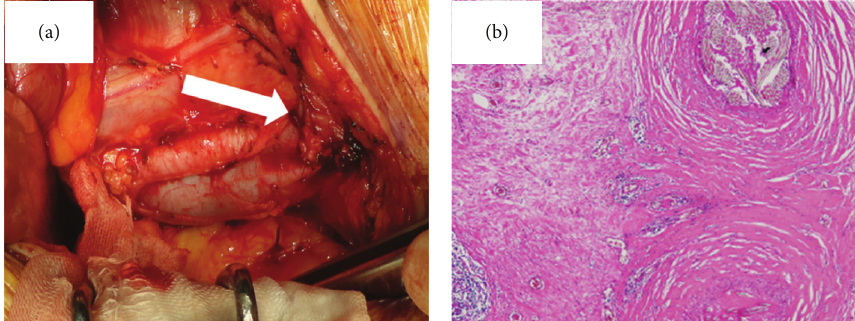
Figure 2: (a) The intraoperative findings revealed tumors near the left femoral artery and vein (arrow). (b) The histopathological findings revealed granulation tissue around the silk ligature surrounding lymphocytic infiltration ×